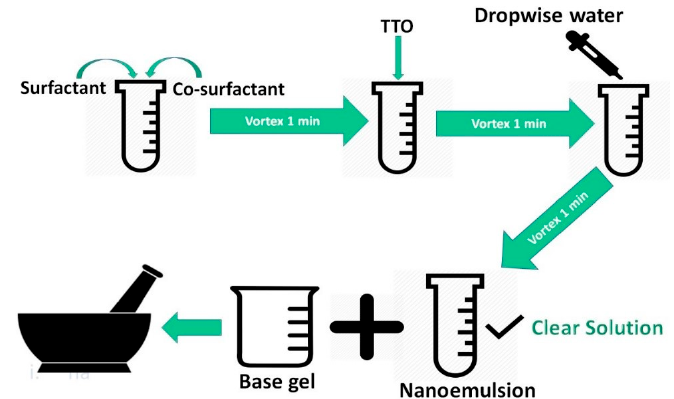
Figure 1. Lipid-based nanoformulations (LNF) development and incorporation into a base gel.